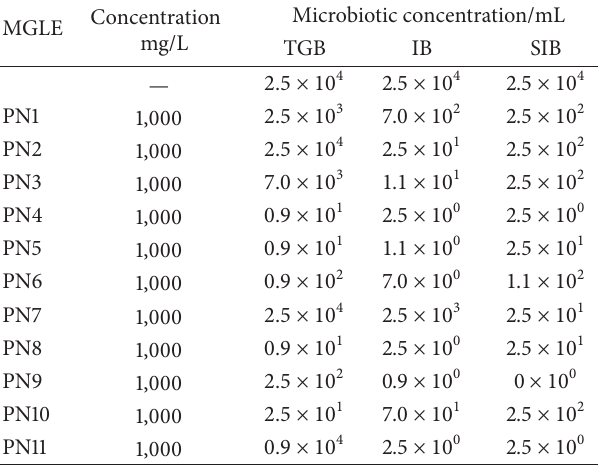
Table 3: The antifungal activity of PN against oilfield waterborne